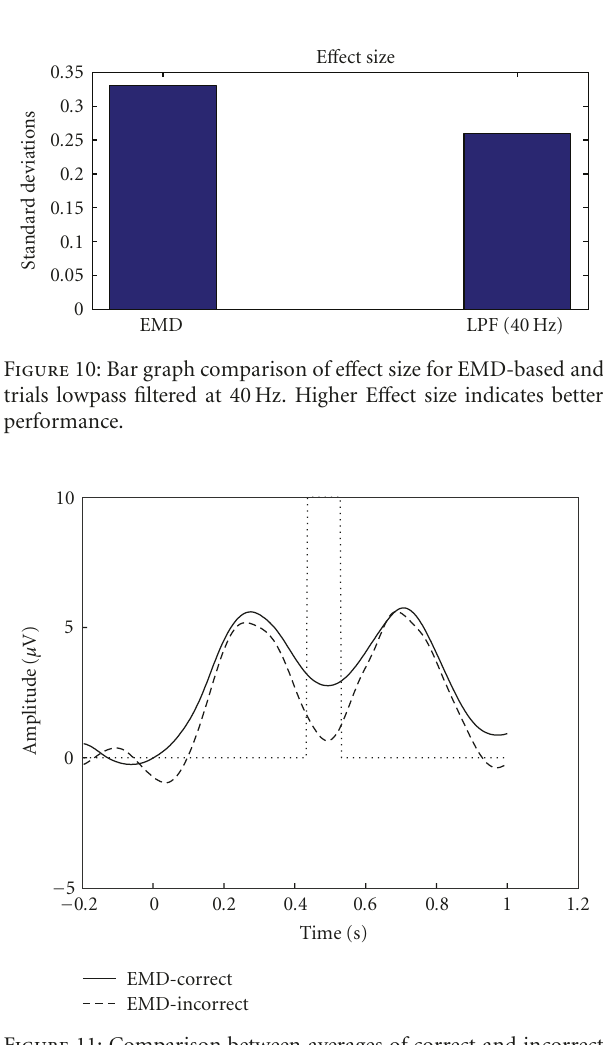
Figure 11: Comparison between averages of correct and incorrect EMD-denoised trials, from condition A. Dotted vertical line indicates time points at which di ff erence between two conditions was significant ( P < .